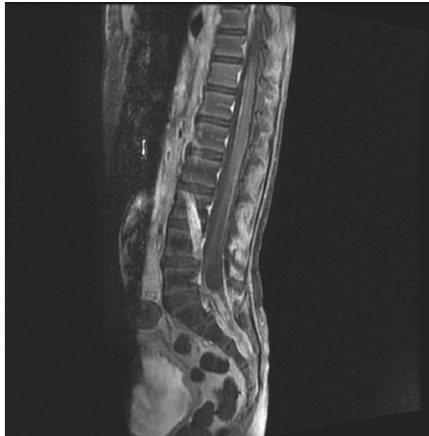
Figure 5: Contrast enhanced sagittal T1 weighted image of the lumbosacral spine showing an enhancing intradural mass extending from L5 to S1 eroding the posterior aspect of S2 denoting intraspinal CSF